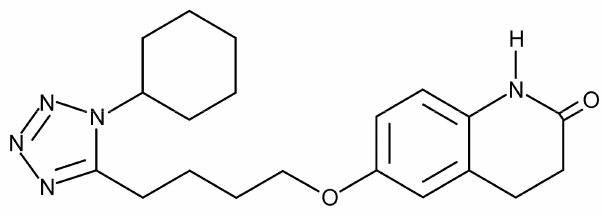
Figure 1. Chemical formula of